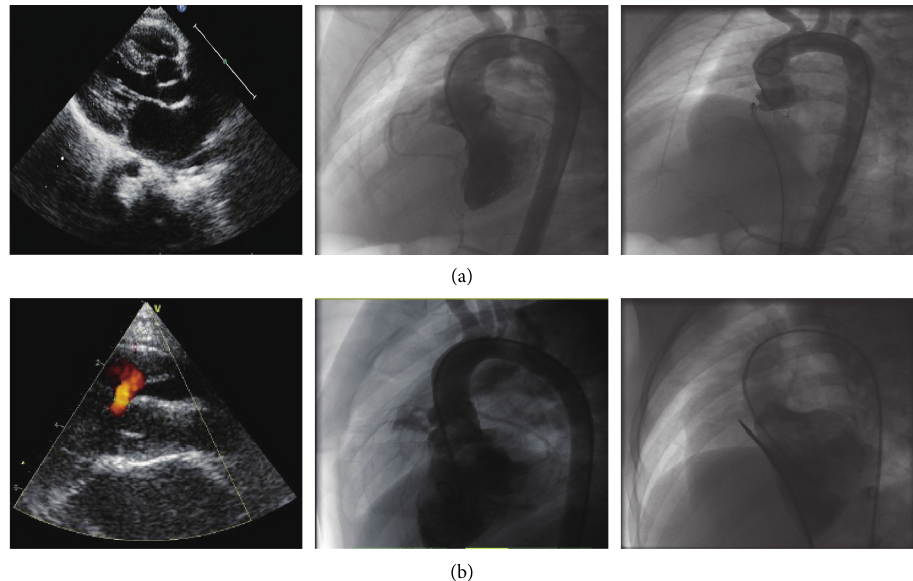
Figure 4: (a) Ventricular septal defect with severe aortic valve prolapse. The right coronary cusp prolapses into the right ventricular outflow tract (left, center). A 5/4mm Amplatzer duct occluder II was successfully implanted without aortic regurgitation as shown by the an- giography (right). (b) Intracristal ventricular septal defect. Transthoracic echocardiography (left) shows the defect is close to aortic valve. Left ventricular angiography at 70 ° left anterior oblique and 20 ° cranial projection was performed to visualize the defect (center). A 5/4mm Amplatzer duct occluder II completely closed the defect completely without residual shunt or interfering with the aortic valve